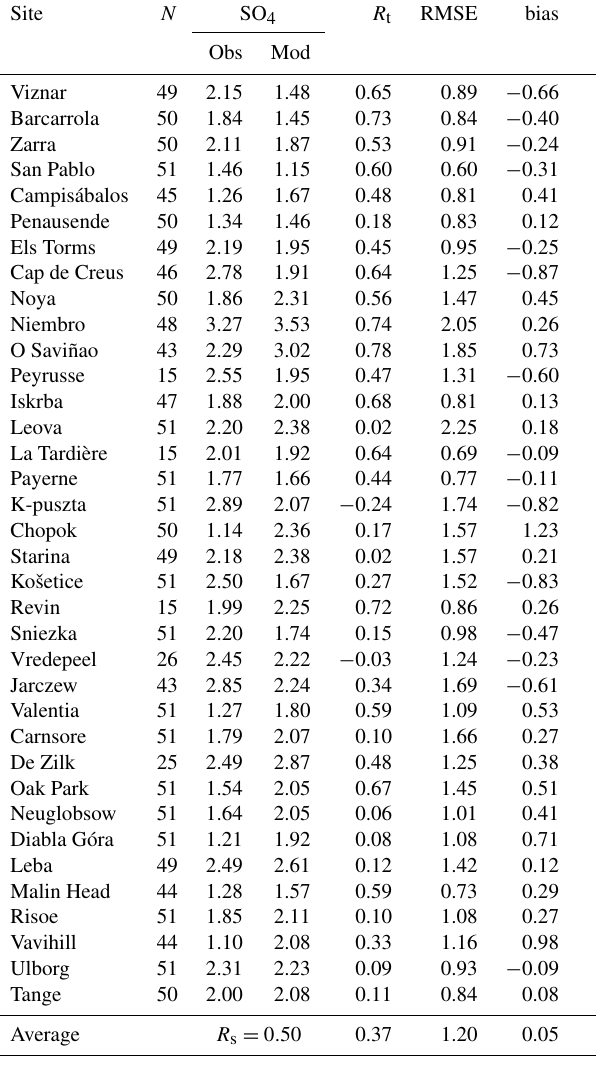
Table 9. Scores for the comparisons between observations (EMEP) and model (CHIMERE) for the SO 4 . Results are presented with N the number of daily mean available measurements for the period from 10 June to 30 July 2013, the temporal correlation ( R t ), the root mean square error (RMSE) and the bias (model minus obser- vations). The last line “average” represents the spatial correlation R s between the mean observed and modeled values and the mean averaged values of correlation, RMSE and bias. Stations are